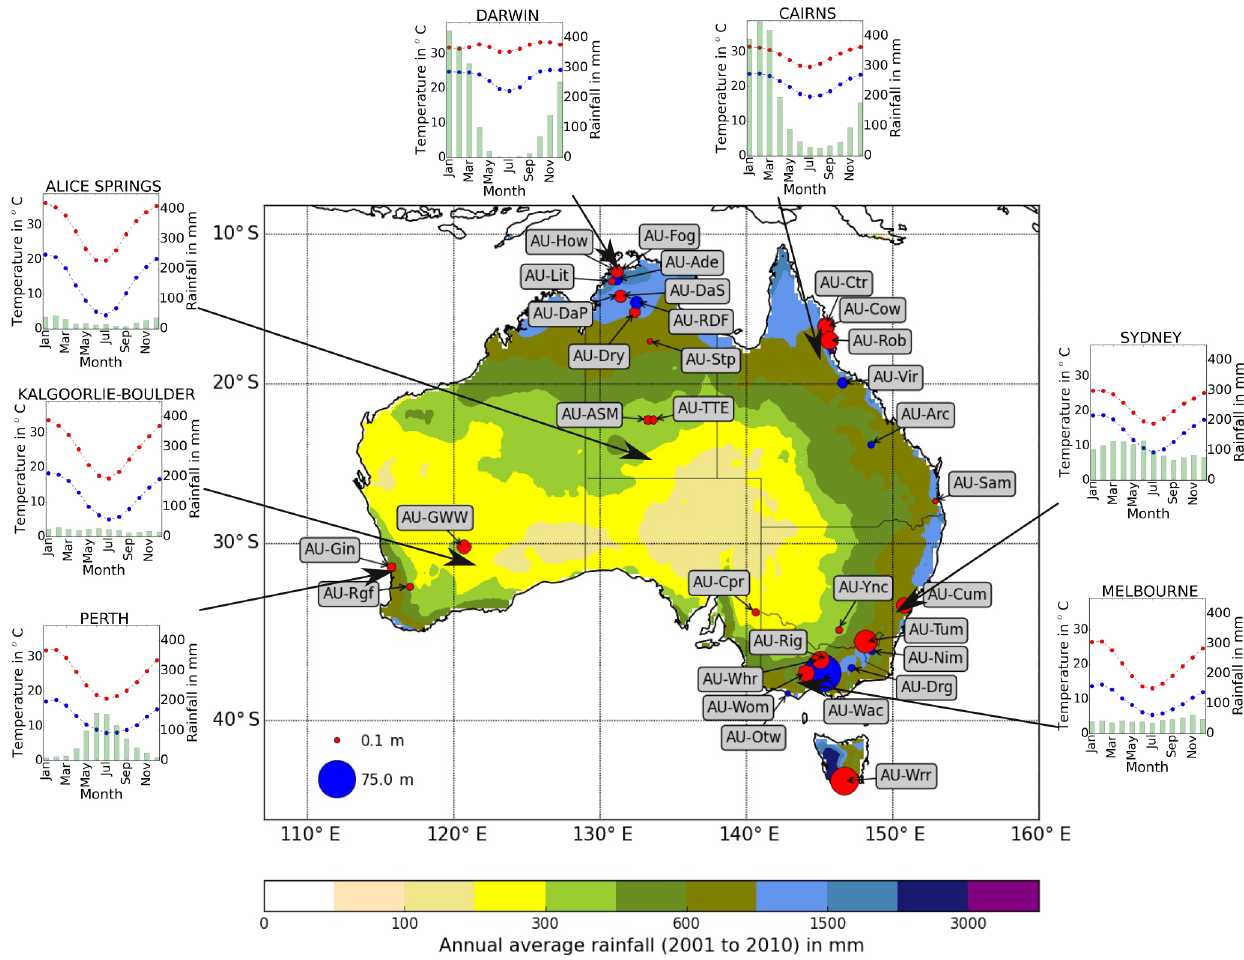
Figure 1. Map of Australia showing the location of OzFlux sites (red for active sites, blue for inactive) and thumbnail plots of monthly average air temperature and precipitation at Bureau of Meteorology sites representative of the tower locations. The diameter of the symbol marking the tower locations is proportional to the canopy height; see scale at bottom